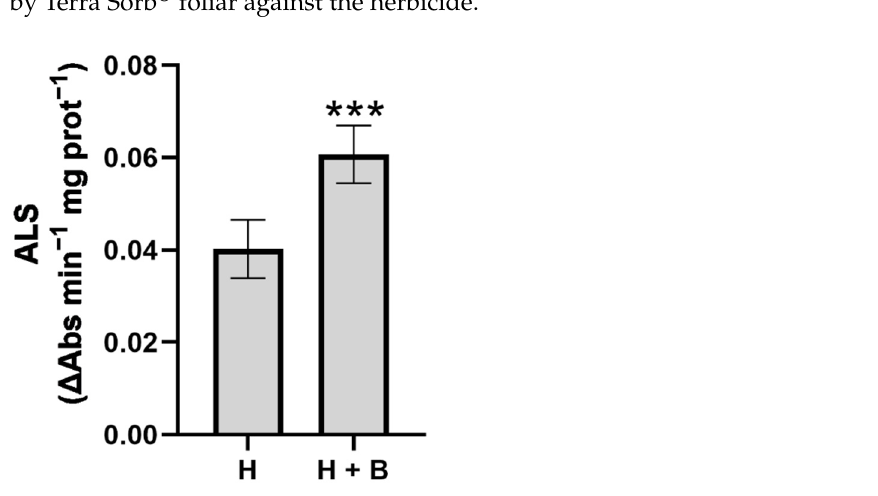
the Pulsar 40 herbicide (Figure 3). This result indicates the protective effect of ALS activity by Terra Sorb ® foliar against the herbicide.